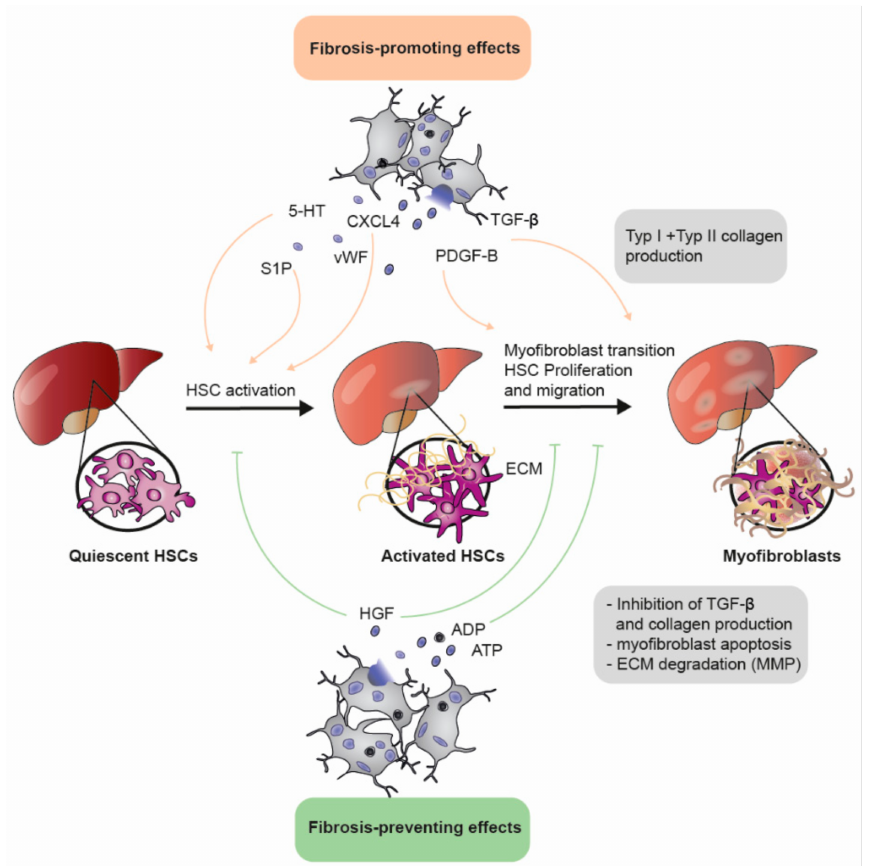
Figure 5. Dual role of platelets in liver fibrosis. The activation of hepatic stellate cells (HSC) leads to the excessive production of extracellular matrix (ECM) proteins, especially type I and type II collagens. This process is promoted by the release of serotonin (5-HT), sphingosine-1-phosphate (S1P) and platelet factor 4 (CXCL4) from platelet granules. Subsequently, platelet-derived growth factor B (PDGF-B) and transforming growth factor- β (TGF- β ) promote the proliferation and differ- entiation of activated HSC into myofibroblasts. In contrast, hepatic growth factor (HGF) as well as adenosine-diphosphate (ADP) and adenosine-triphosphate (ATP) released from platelets counteract both processes and therefore play a beneficial role in liver